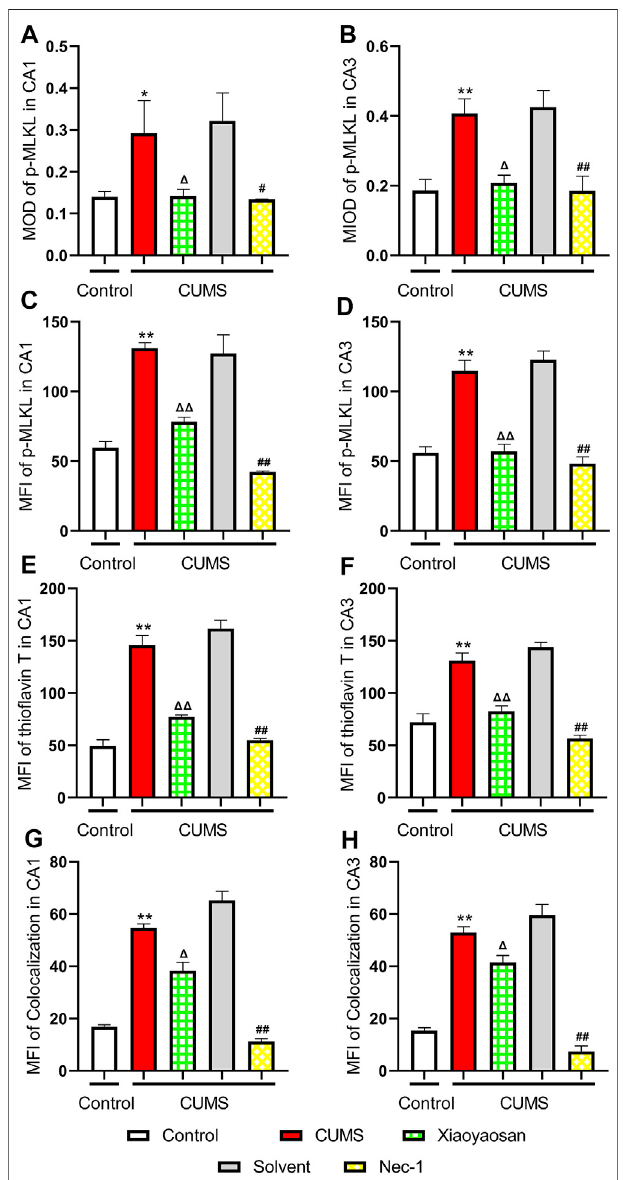
FIGURE 8 | Expression of p -MLKL in CA1 and CA3 regions of the hippocampus (A) The MOD level of p -MLKL in the CA1 region (n (cid:1) 5) (B) The MOD level of p -MLKL in the CA3 region (n (cid:1) 5) (C) The MFI level of p -MLKL in the CA1region(n (cid:1) 5) (D) TheMFIlevel of p -MLKLintheCA3 region(n (cid:1) 5) (E) TheMFIlevelofthio fl avineTstainingintheCA1region(n (cid:1) 5) (F) TheMFI level of thio fl avine T staining in the CA3 region (n (cid:1) 5) (G) The MFI level of p -MLKL colocalized with thio fl avin T staining in the CA1 region (n (cid:1) 5) (H) The MFIlevelof p -MLKLcolocalizedwiththio fl avinTstainingintheCA3region(n (cid:1) 5).Datawereexpressedasmeans ± SEM,* p < 0.05,** p < 0.01versuscontrol group; Δ p < 0.05, ΔΔ p < 0.01 versus CUMS group; # p < 0.05, ## p < 0.01 versus solvent